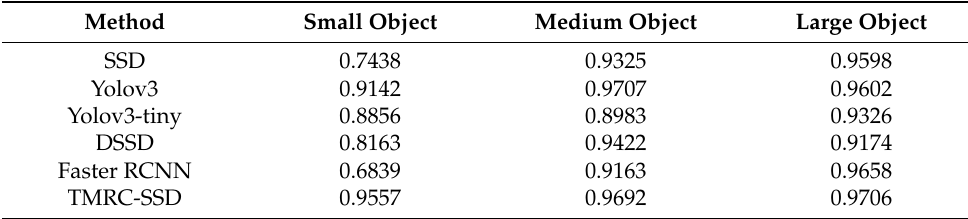
Table 5. Performance with different components for three scales of objects.